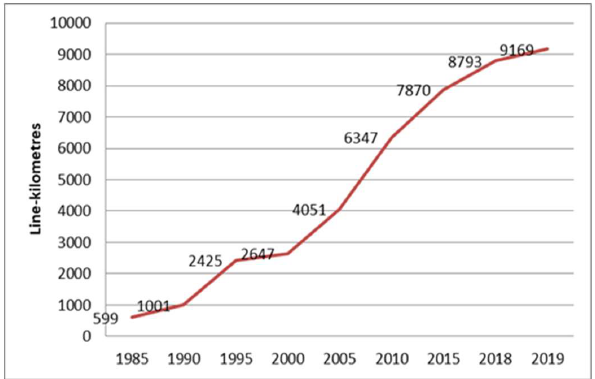
Figure 1. Development of a high-speed railway network in Europe [9] Figure 2. provides an overview of the length in kilometers of high-speed railway routes in selected European countries in 2019. Spain was the country with the longest high-speed railway, with a total length of 3,297 kilometers. After that, France and Germany had the longest high-speed railways among these countries, with 2,734 and 1,571 kilometers [9]. Austria recorded the shortest high-speed railway line among countries, with a total length of 67 kilometers.